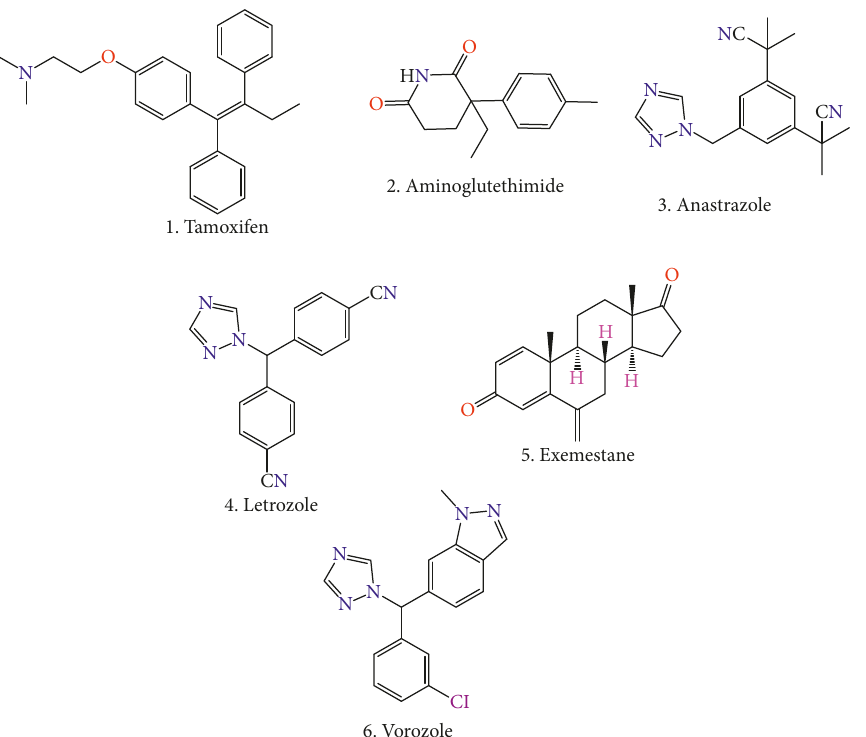
Figure 1: Chemical structure of the commonly used drugs for the treatment of hormone-dependent breast